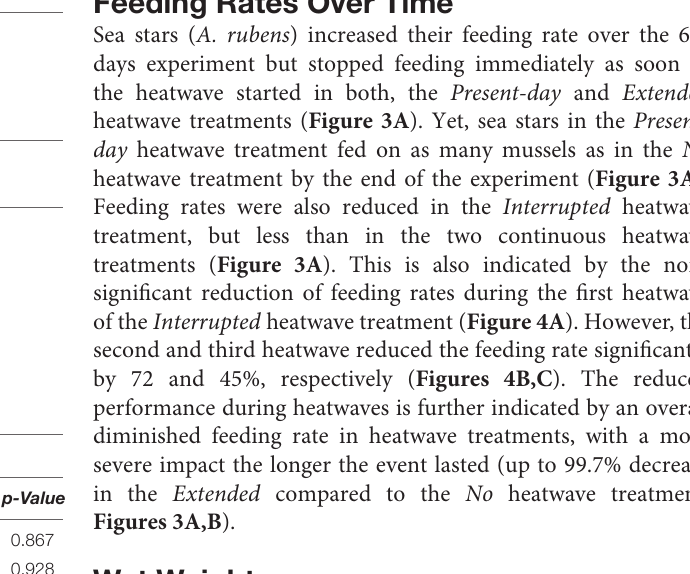
Table 1 ). At the same time, cold-spells occur twice per year on average with a mean duration and intensity of 12.7 days and 3.7 ◦ C, respectively ( Supplementary Table 2 ). These parameters GAMM righting time differ throughout the seasons ( Supplementary Tables 1, 2